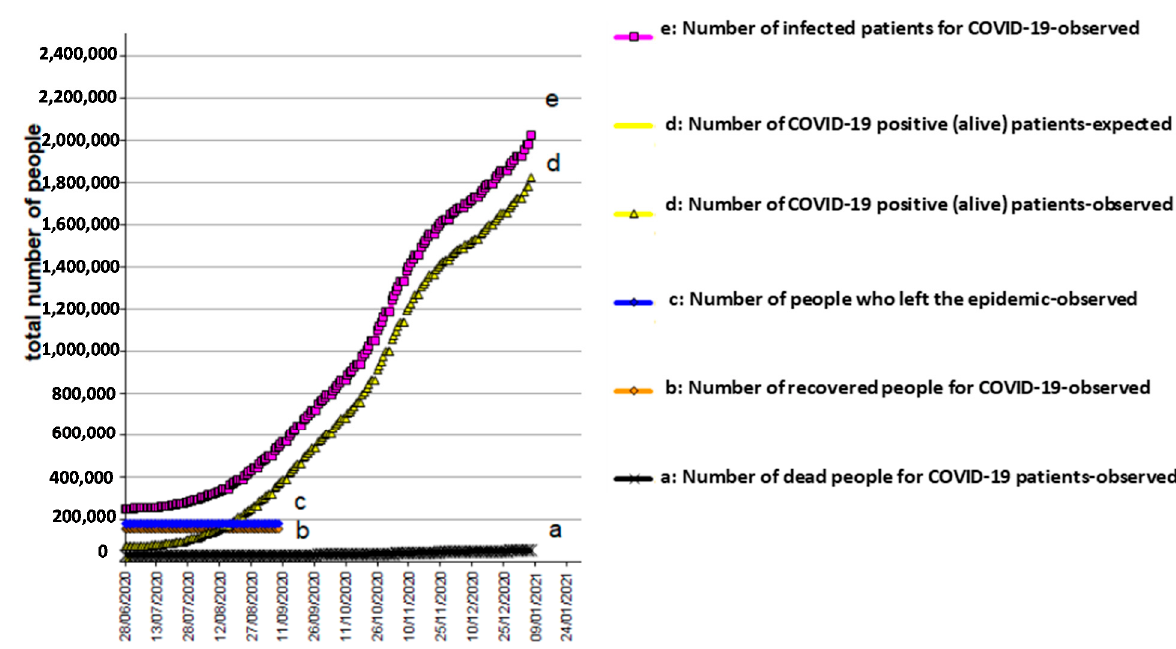
Figure 5. COVID-19 epidemic time-course in Spain during the second wave.